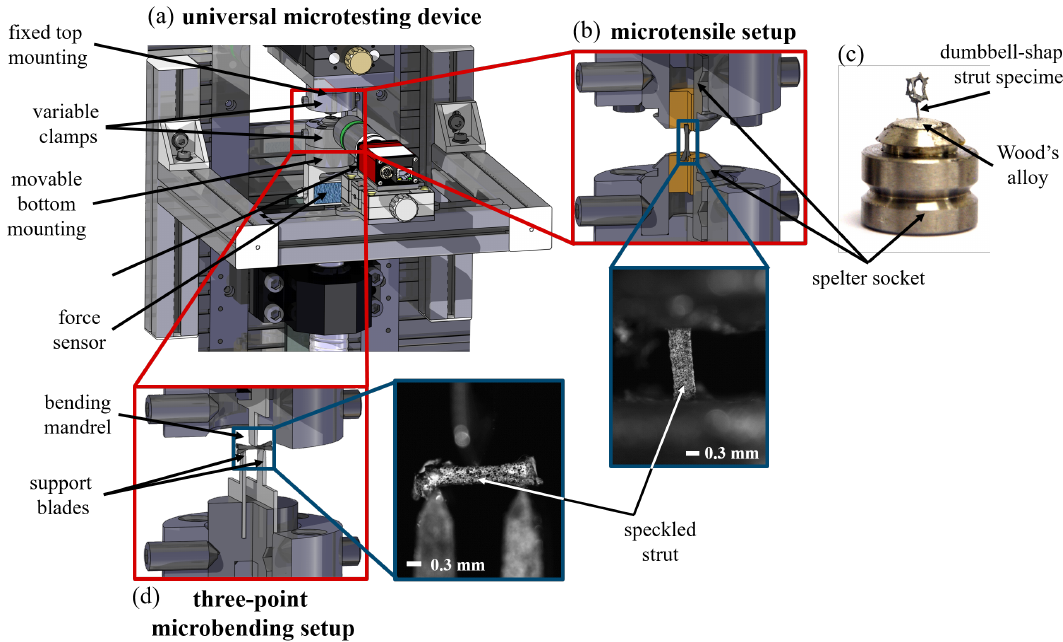
Figure 1. Experimental setup for micromechanical experiments: ( a ) detail of the universal micromechanical testing device including the different modules for ( b ) microtensile testing and ( d ) three-point microbending experiments on individual struts; ( c ) shows the dumbbell-shaped strut specimen for tensile testing already moulded into the spelter socket on one side by Wood’s